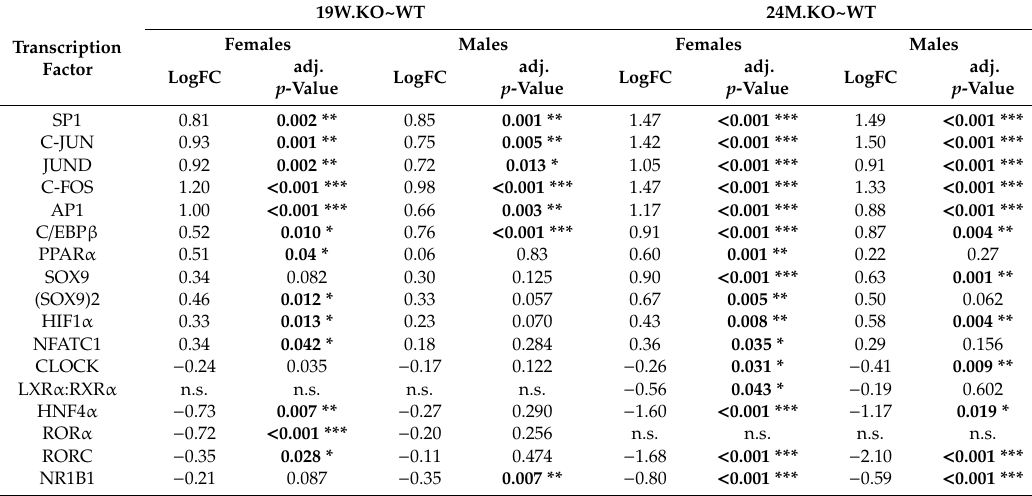
Table 2. The most significantly enriched TFs in 19W KO (19W.KO~WT) and 24M KO (24M.KO~WT). Parameters shown in bold are statistically significant. * p < 0.05, ** p < 0.01, *** p < 0.001; n.s.—not significant. SP-1: Specificity protein 1; AP1: Activator protein 1; C / EBP β : DNA damage-inducible transcript 3; PPAR α : Peroxisome proliferator-activated receptor alpha; HIF1 α : Hypoxia-inducible